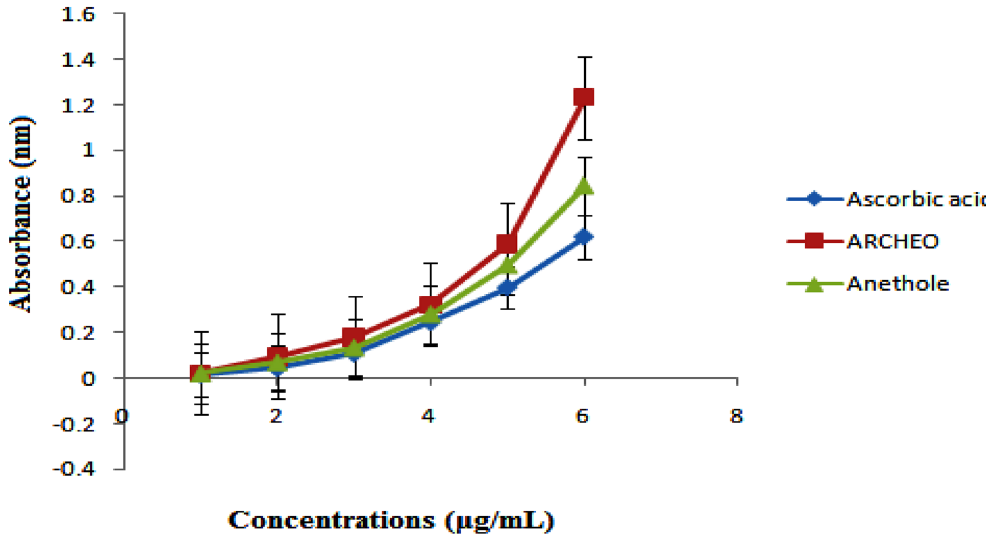
Figure 2. Reducing power activities of ARCHEO , anethole and ascorbic acid with standard error